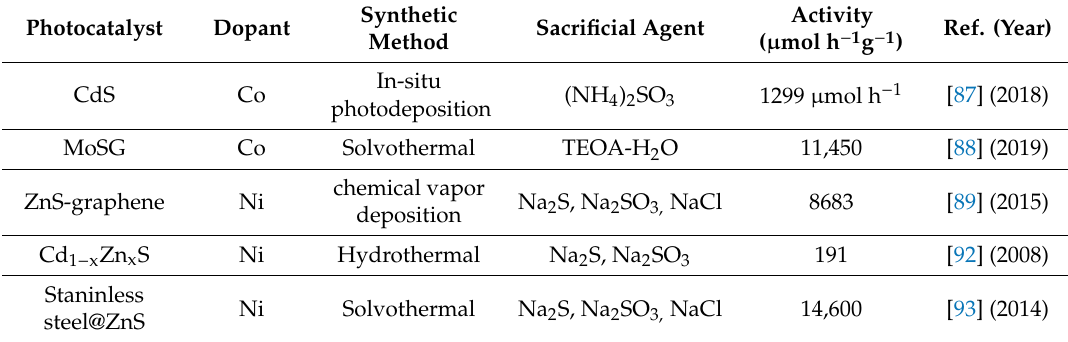
Table 8. Photocatalytic hydrogen production performances for transition metal doped